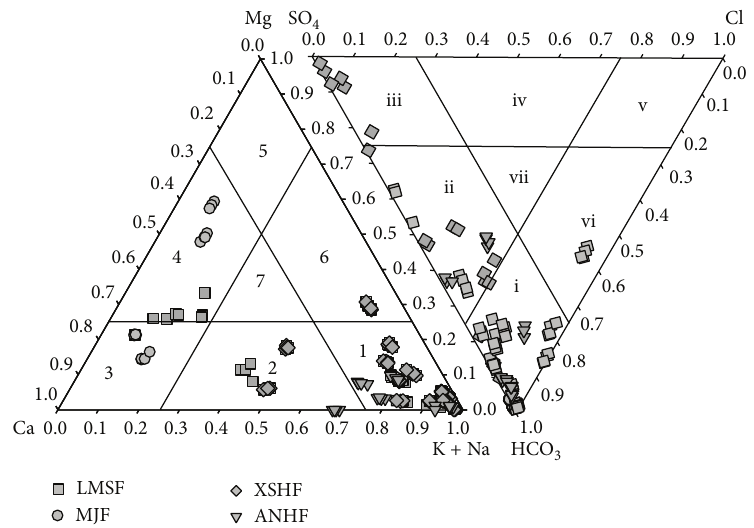
Figure 2: Ternary plots of the cation and anion for the waters.